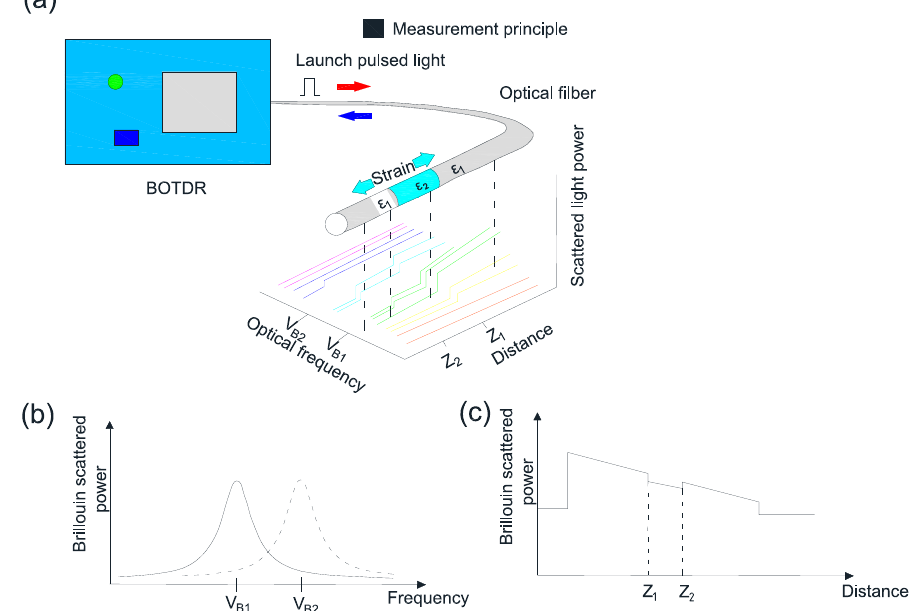
Figure 7. Principle of the Brillouin Scattering-based fiber optic measuring technique: ( a ) The Brillouin scattering spectrum along an optical fiber; ( b ) The Brillouin scattering spectrum at a specific frequency; ( c ) The Brillouin scattering spectrum at a specific location.